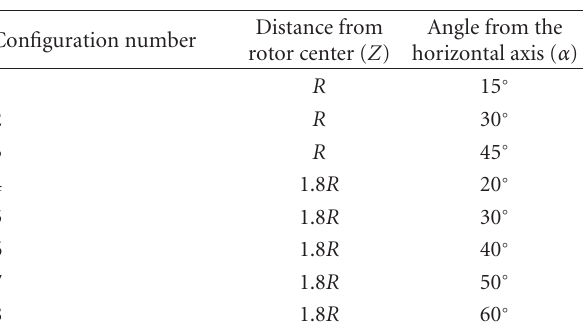
Table 2: Geometrical parameters for deflector plate positioning on the advancing blade